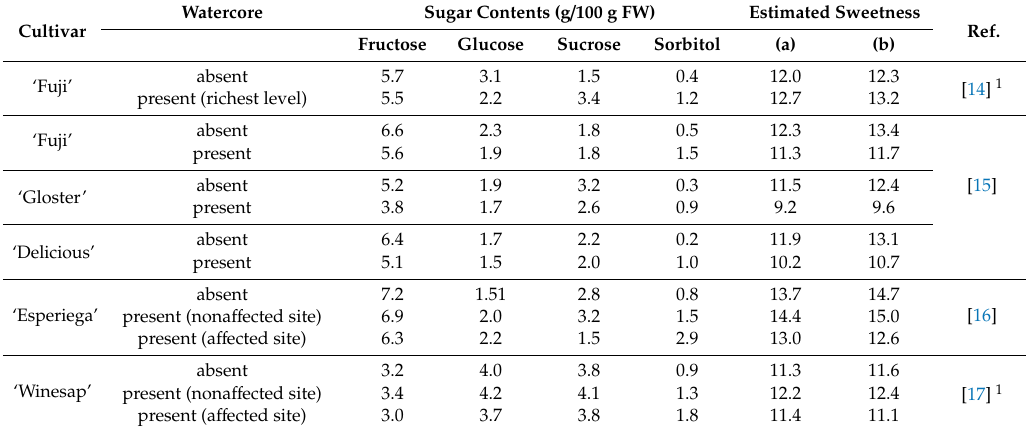
Table 2. Sugar profiles and estimated perceived sweetness of various apple cultivars. Cultivar